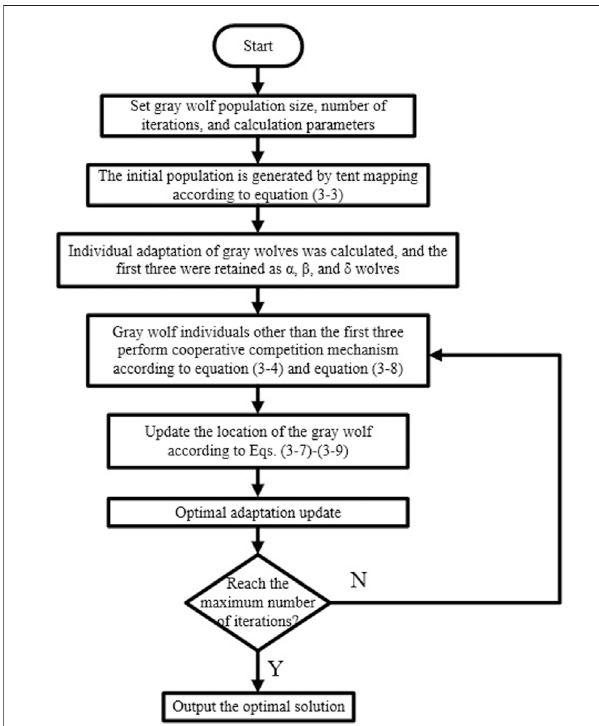
FIGURE 2 | Flow chart of the improved gray wolf optimization algorithm.